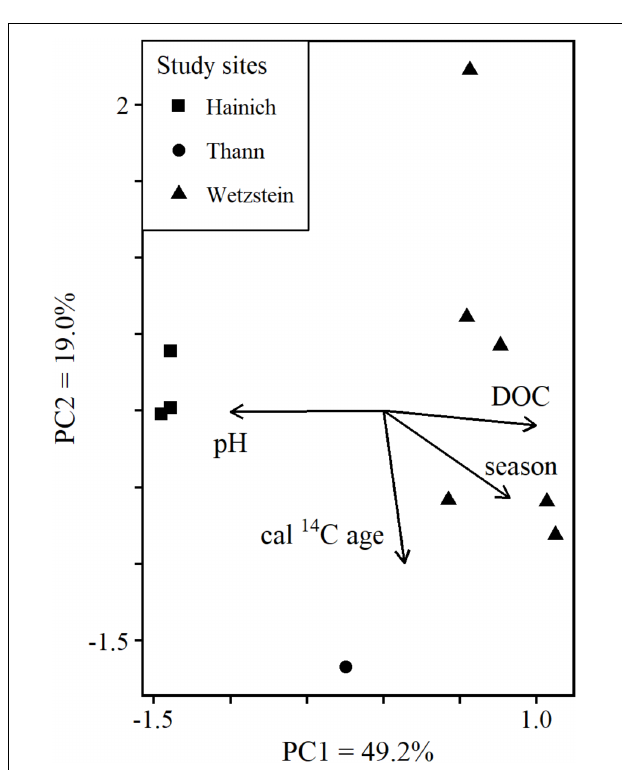
FIGURE 2 | Ordination plot from PCA based on the molecular composition of samples with cal. age data. All masses with molecular formula assignment and their normalized FT-ICR-MS intensities were used for calculating the PCA. DOC concentration, pH, growing season and cal. age were fitted as environmental